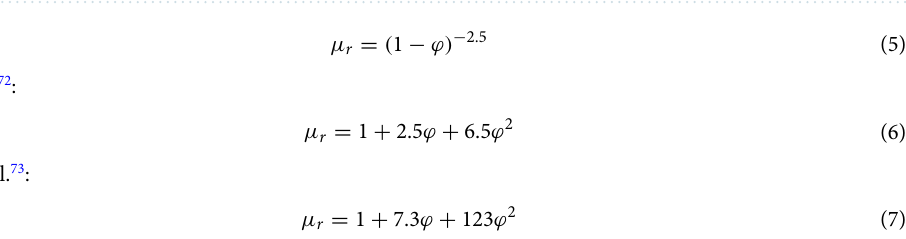
Figure 7. Dynamic viscosity versus shear rate for different temperature and VFs of ( a ) 0%, ( b ) 0.25%, ( c ) 0.5%, ( d ) 0.75%, ( e ) 1%, ( f ) 1.25%, ( g )